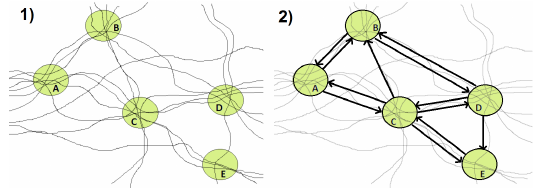
Figure 5: Using a places extraction algorithm for creating the graph as basis for the prediction algorithm